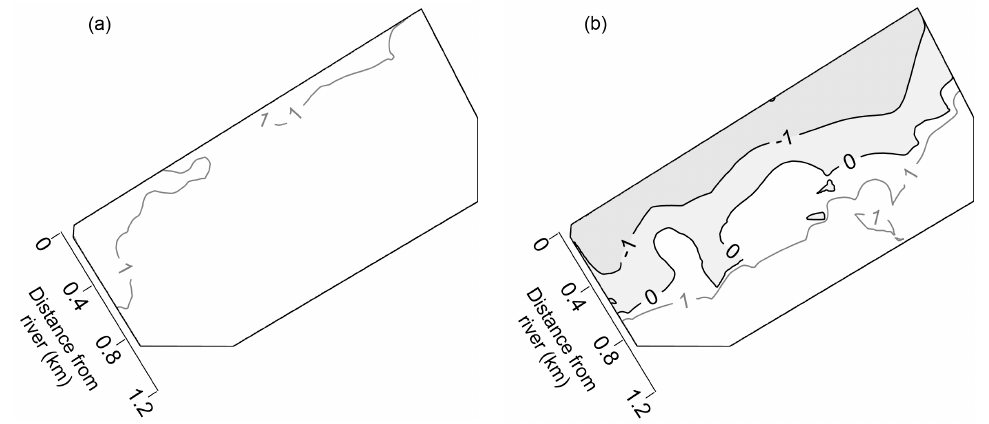
Figure 7. Simulated results incorporating the spatial variation of pumping available thickness (PAT) values when the river level is ( a ) 4.2 m and ( b ) 1.4 m, respectively.